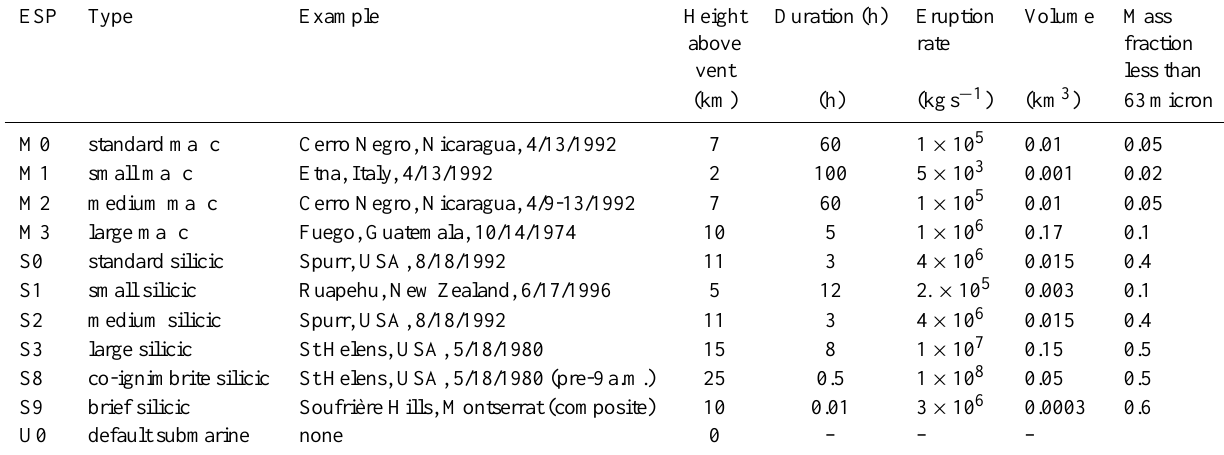
Table 1. Injection height, duration, eruption rate, volume and mass fraction ( < 63µm) as provided by Mastin et al. (2009) and used to determine the eruption properties within the WRF-Chem model. Adapted from Mastin et al. (2009).